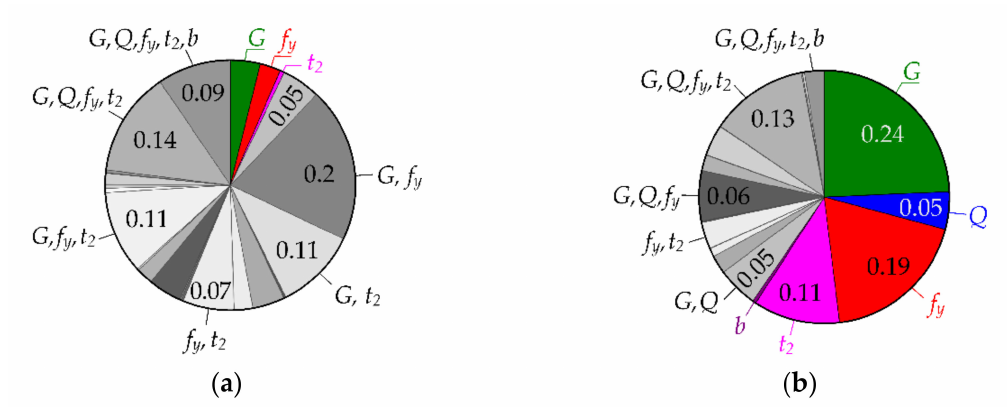
Figure 9. The results of SA for P f = 4.8 × 10 − 4 using: ( a ) P4 M ( P f ), Equation (27); ( b ) L M ( P f ), Equation